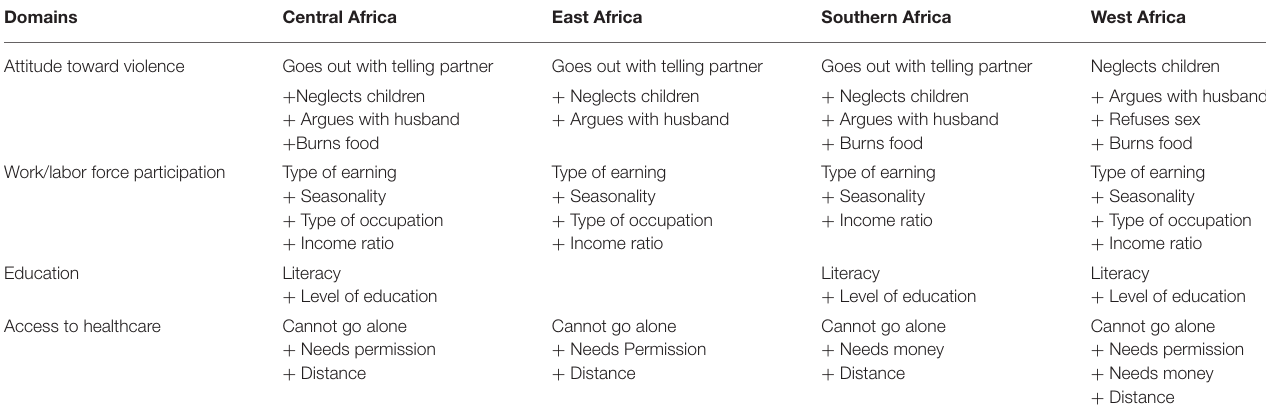
TABLE 2 | The four domains for empowerment as determined by exploratory factor analysis (latent variables analysis), with final composition after confirmatory factor analysis and model refinement by regions.